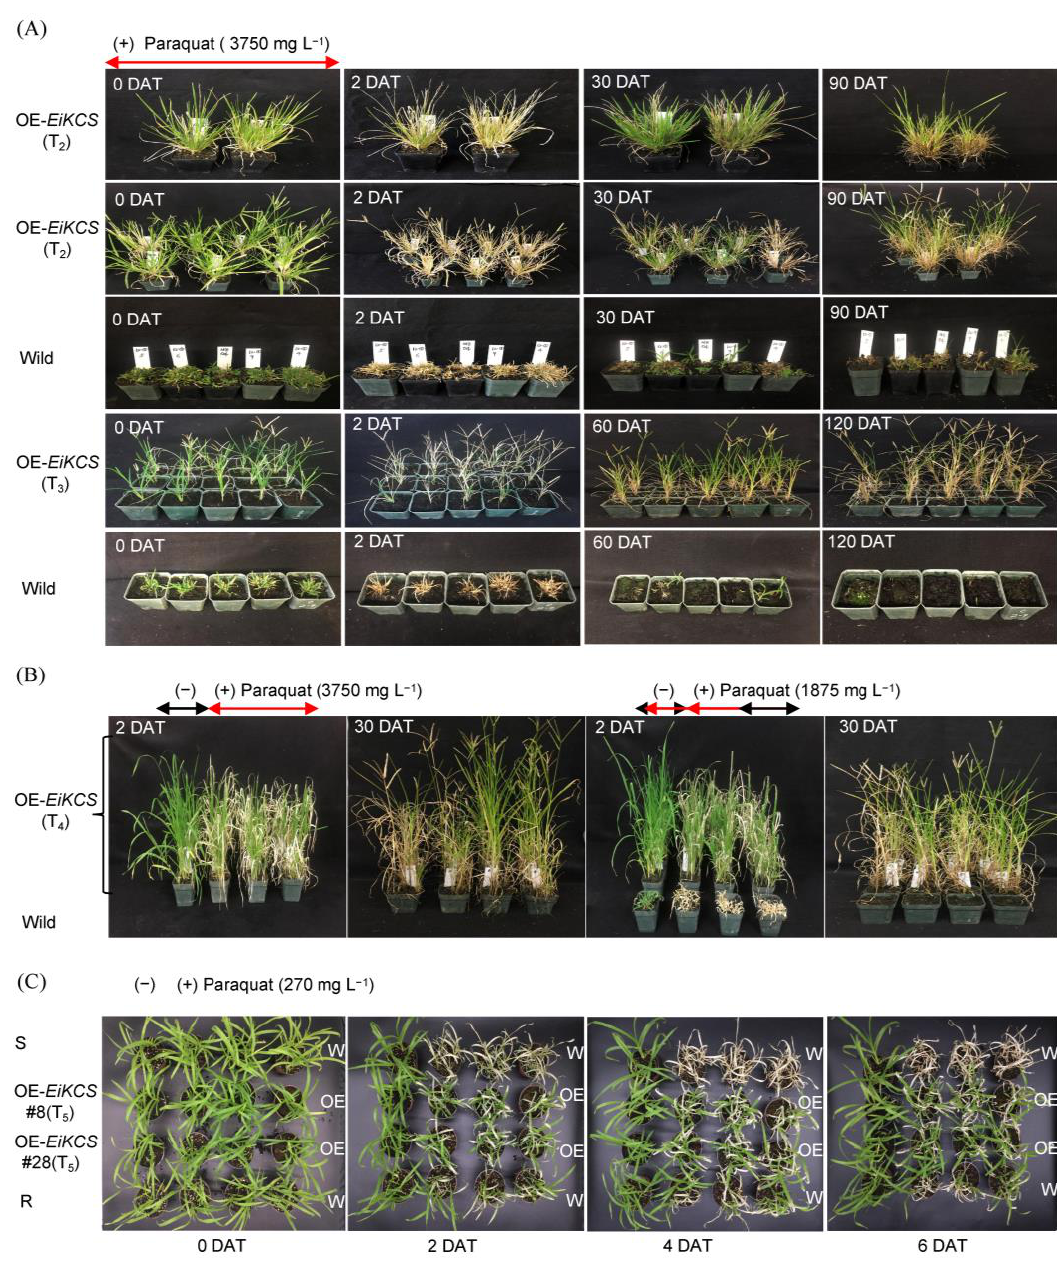
Figure 5. Paraquat resistance of the transgenic goosegrass plants. ( A ) The resistant phenotypes of transgenic goosegrass (T 2 and T 3 generation) at the vegetative or reproductive stage in 120 days after spraying 3750 mg L − 1 paraquat. Wild type means the susceptible goosegrasses (MZ04) used as the control. ( B ) The resistant phenotypes of transgenic goosegrass (T 4 generation) at reproductive stage in 30 days after spraying 3750 mg L − 1 and 1875 mg L − 1 paraquat. Wild type means the susceptible goosegrasses (MZ04) used as the control. ( C ) The resistant phenotypes of the transgenic lines line-8 and line-28 (T 5 generation) after treatment with 270 mg L − 1 paraquat. R means a naturally selected resistant-biotype goosegrass (QY05), and S means the susceptible goosegrasses (JM) used as the control. W means wild-type goosegrass of natural evolution, and OE means the overexpressing EiKCS of transgenic weeds. DAT means days of treatment.